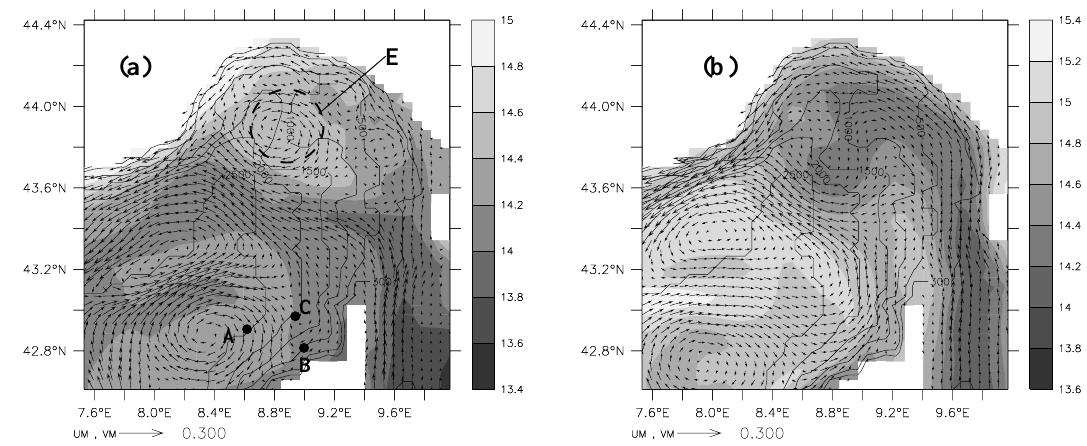
Fig. 6. Temperature (shaded, in ◦ C), velocity (arrows, incm/s) at 50m, and bottom topography (isobaths) in the Ligurian Sea in: (a) June, year I; (b) December, year I. A, B and C denote locations of the current meters during the PRIMO-0 experiment (Taupier-Letage and